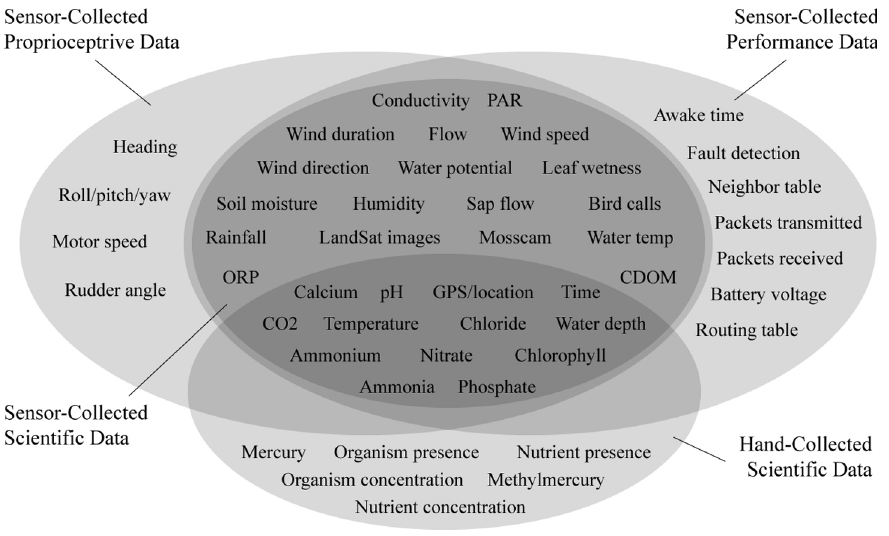
Figure 1. CENS data types organized by collection method and use (adapted from [ 47 ] ).